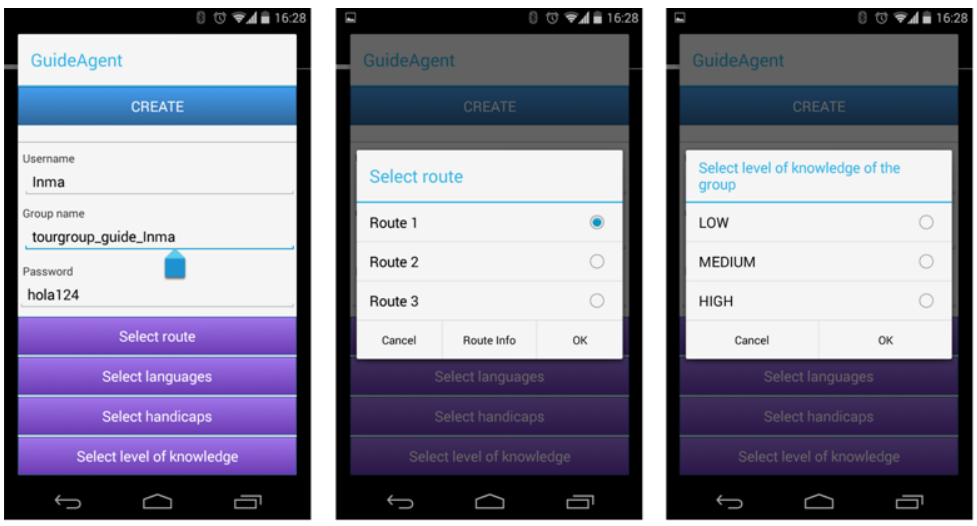
Figure 13. Snapshots of the guide interface for the selection of tour